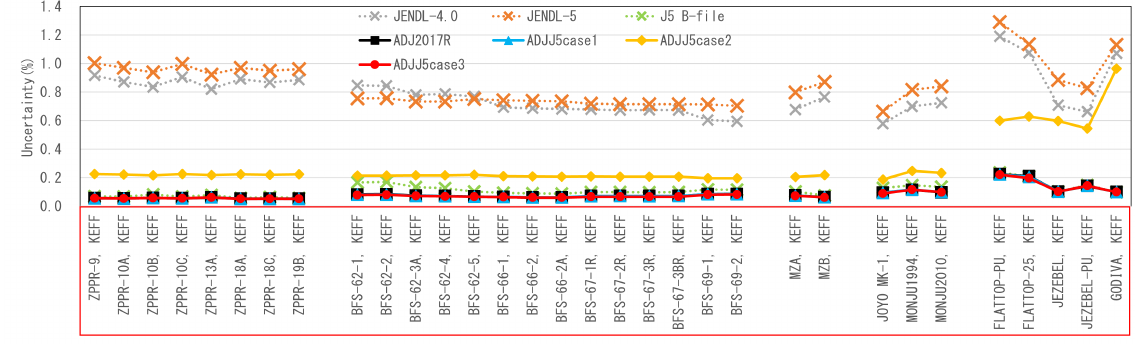
Figure 5. Nuclear-data-induced uncertainty of criticality